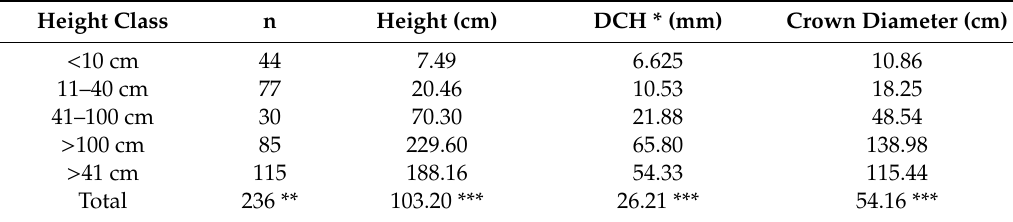
236 ** 103.20 *** 26.21 *** 54.16